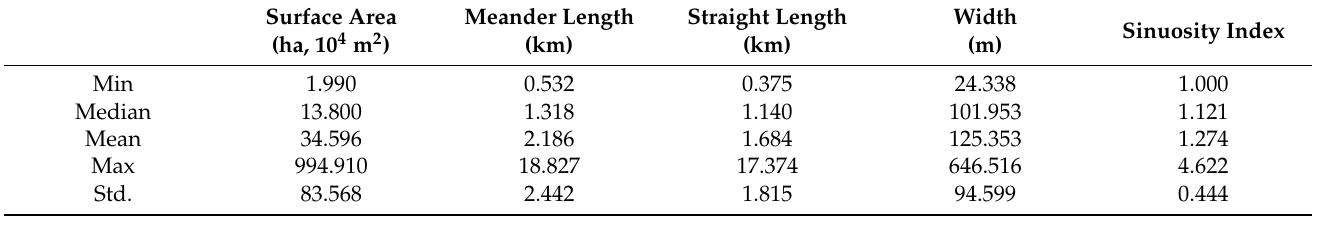
Table 5. The planform geometric attributes of delineated links.